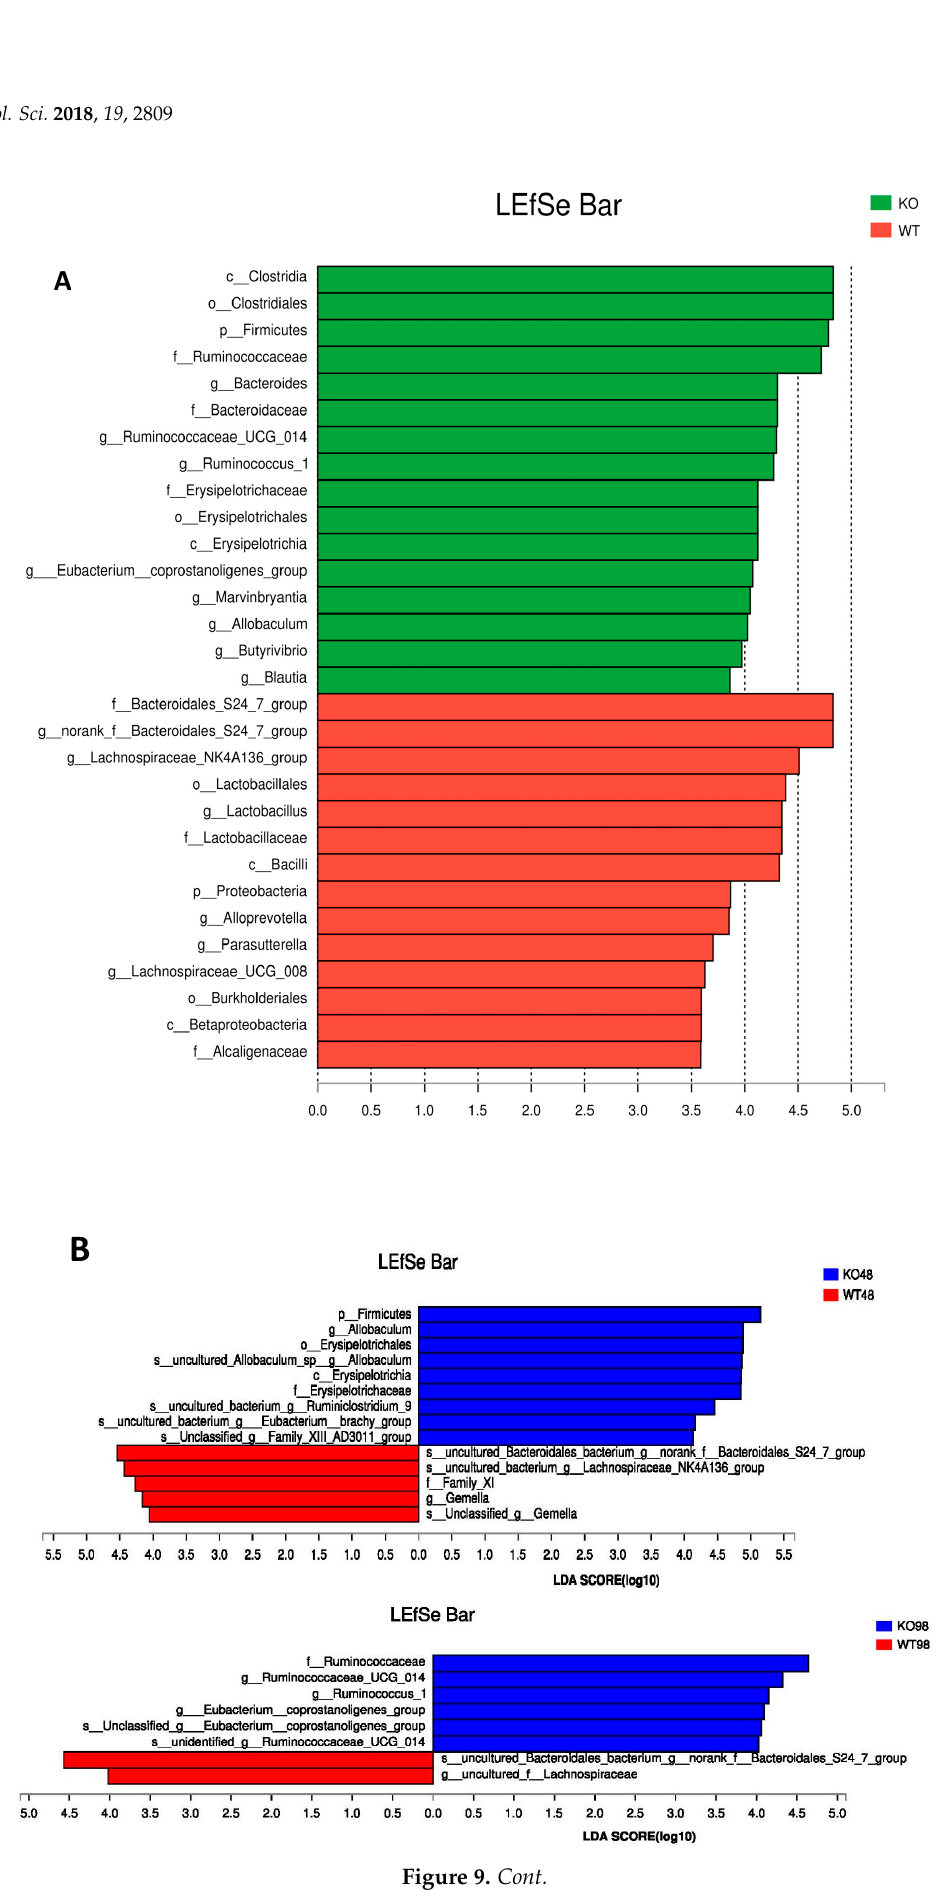
Figure 9. Linear discriminant analysis (LDA) coupled with effect size measurement (LEfSe) analysis of gut microbes among Muc2 − / − and Muc2 +/+ mice. ( A ) Histogram of the linear discriminant analysis (LDA) scores for differentially abundant genera among Muc2 − / − and Muc2 +/+ mice; ( B ) the LEfSe analysis at different time points. WT, Muc2 +/+ mice; KO, Muc2 − / − mice. Interestingly, Roseburia, Butyricimonas, Coprococcus, Clostridium, Ruminococcus , and Eubacterium detected in this study are, in fact, butyrate-producing bacteria in the gut. As shown in Table 1, the total abundances of butyrate-producing bacteria were significantly higher in Muc2 − / − mice than those